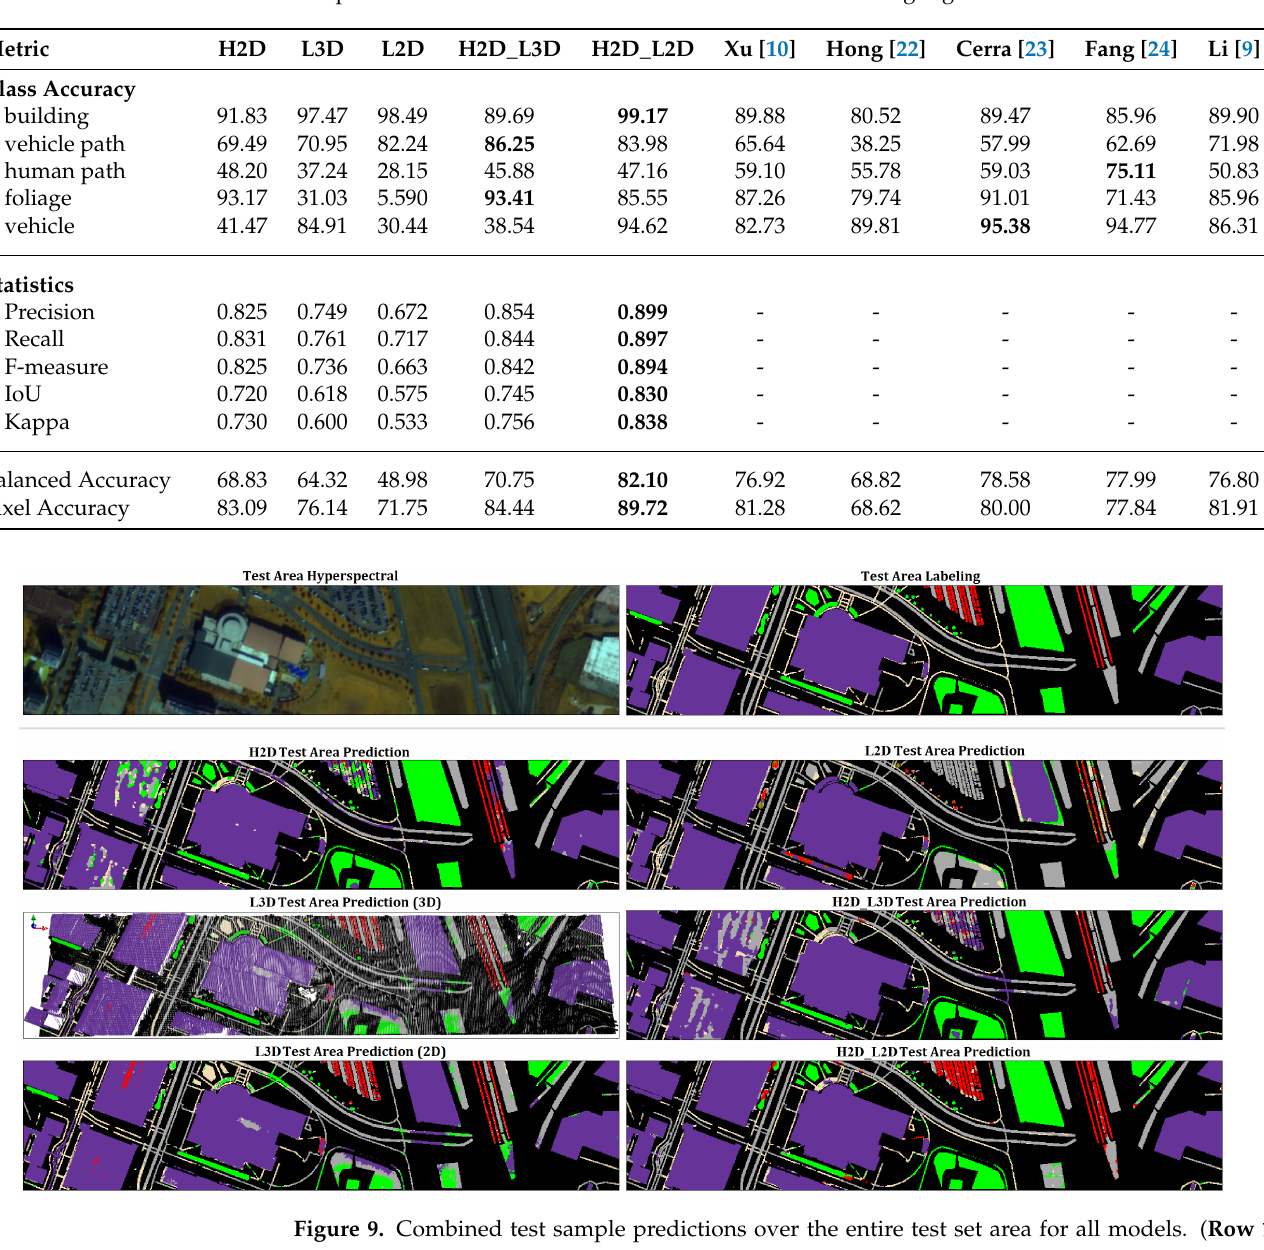
Table 3. Experimental results and comparison to previous work’s translated results. Translation computed as described in Section 2.1.3. The best results are highlighted in bold.